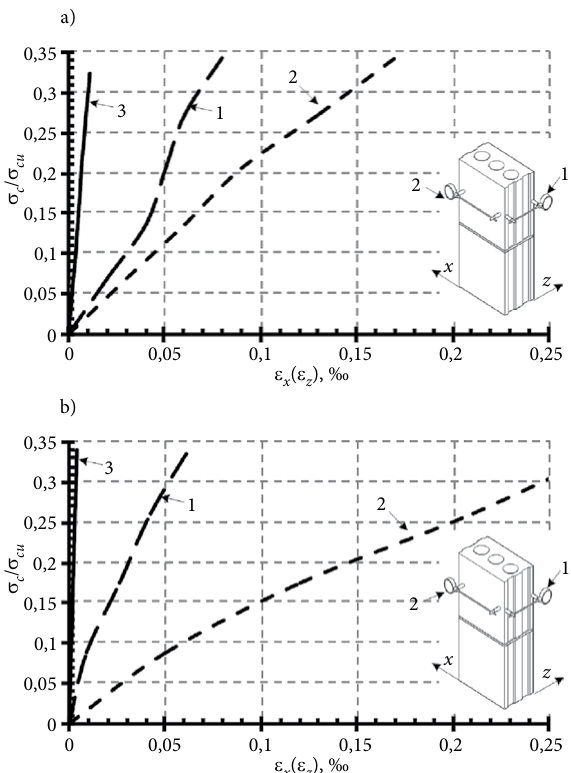
Fig. 5. The comparison between curves of experimental horizontal strain e z (1), e x (2) and theoretical horizontal strain (3) form formula 2: a – thick bed joint;